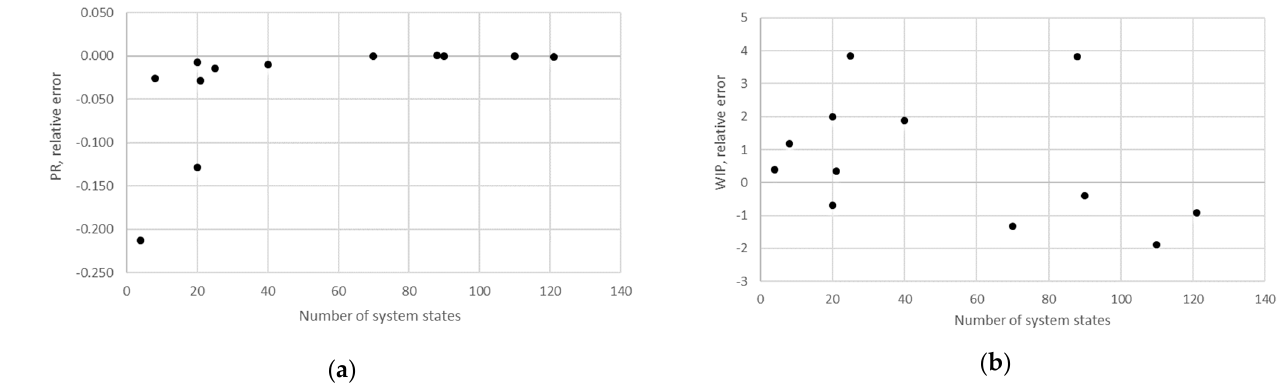
Figure 21. The relative error of the WIP concerning the number of machines—numerical method.